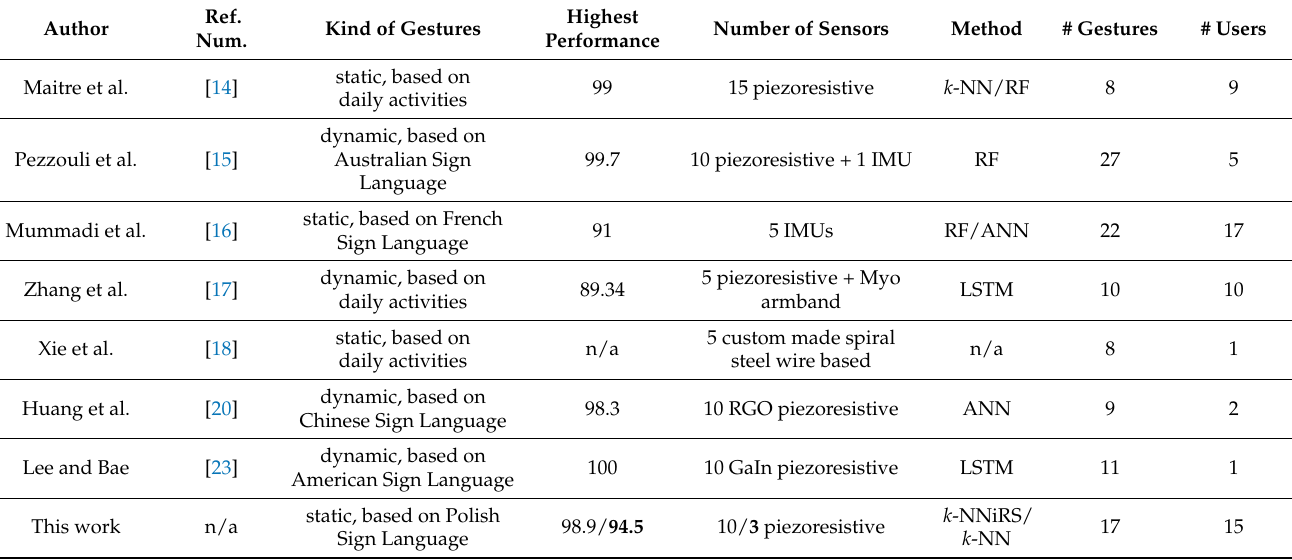
Table 3. Comparison of the results presented in this paper to articles in Related